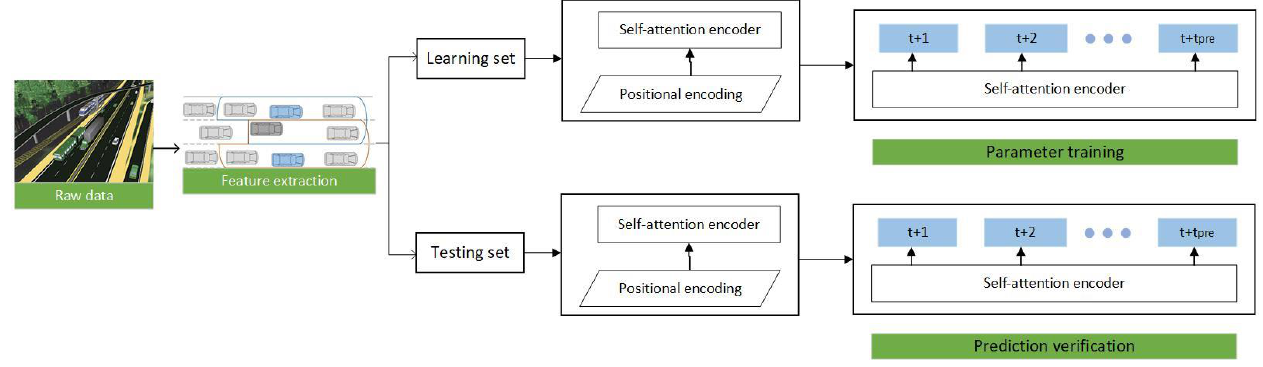
Figure 1. Framework of proposed prediction approach.